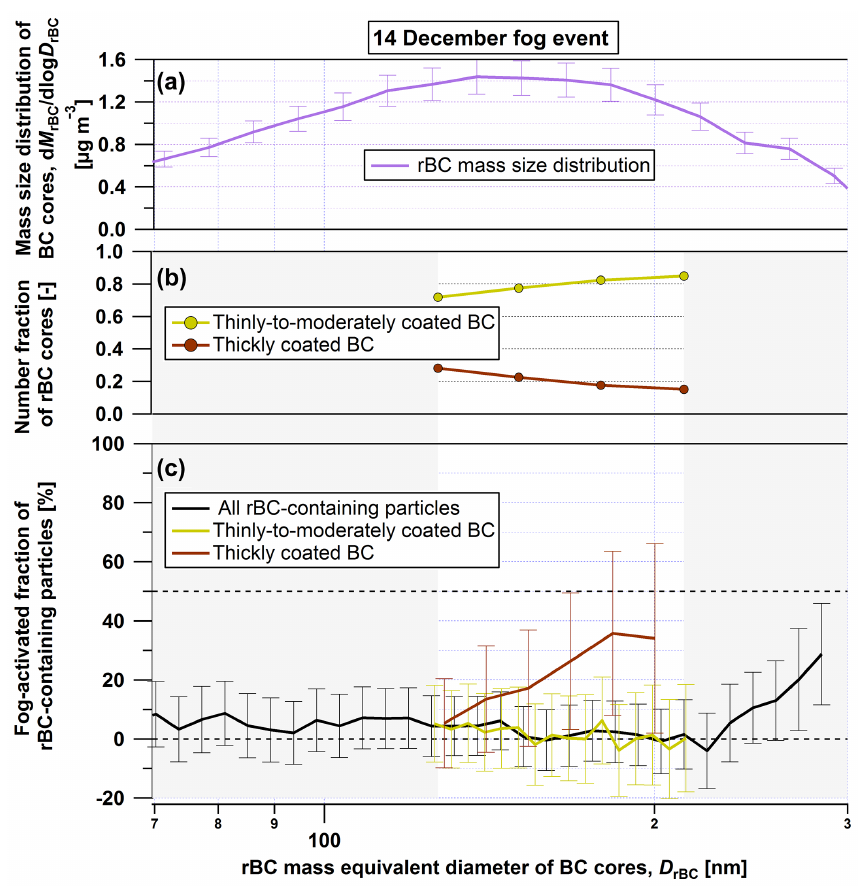
Figure 8. BC-containing particle properties and behaviour during the December 14 fog event as a function of rBC mass equivalent diameter of the BC cores: (a) rBC mass size distribution (total inlet), (b) number fractions of BC-containing particles split in two mixing state classes (total inlet), (c) fraction of BC-containing particles activated to fog droplets (based on alternating measurements behind the interstitial and total inlets). The two mixing state classes shown in panels (b) and (c) are distinguished by either thick or thin-to-moderate coatings based on the delay-time method applied to the SP2 raw data. The 1 σ uncertainties in panel (c) are Poisson-based counting statistics for the rBC core number size distributions propagated through the equation of the fog-activated fraction. The mixing-state-resolved data are only shown for the mass equivalent diameter range 127nm< D rBC < 212nm, in which detection limits of the SP2 do not introduce any systematic bias. The most thickly coated particles which caused saturation of the scattering signal were included in the subset of BC particles with thick